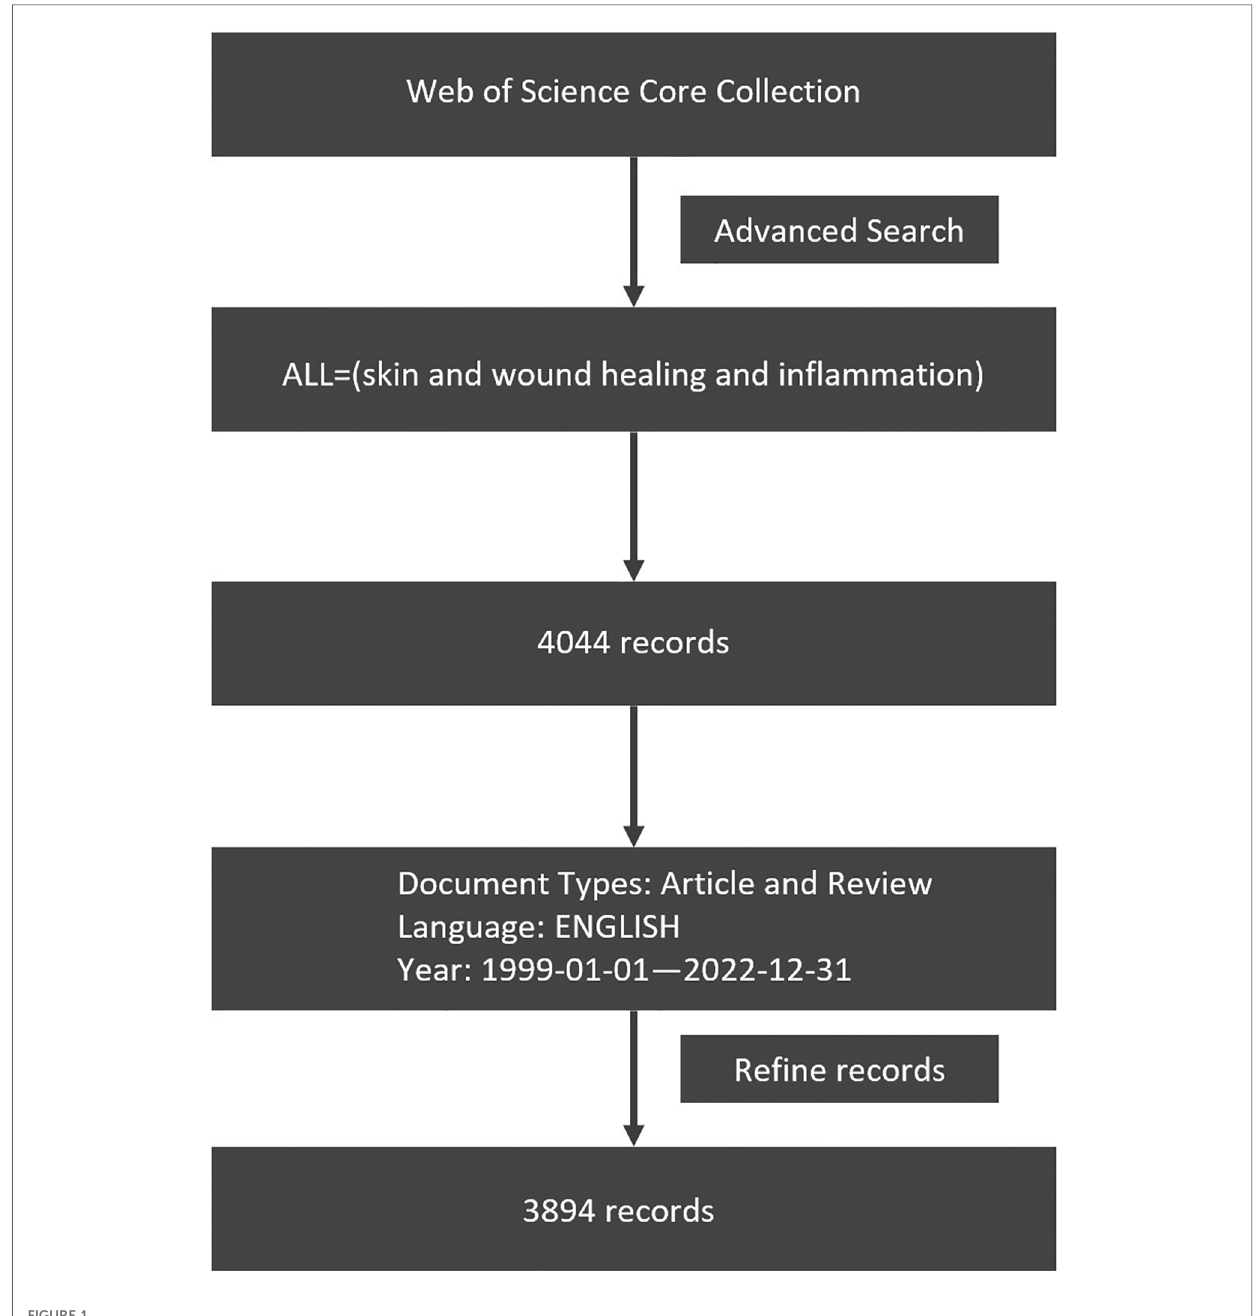
FIGURE 1 The data collection and retrieval